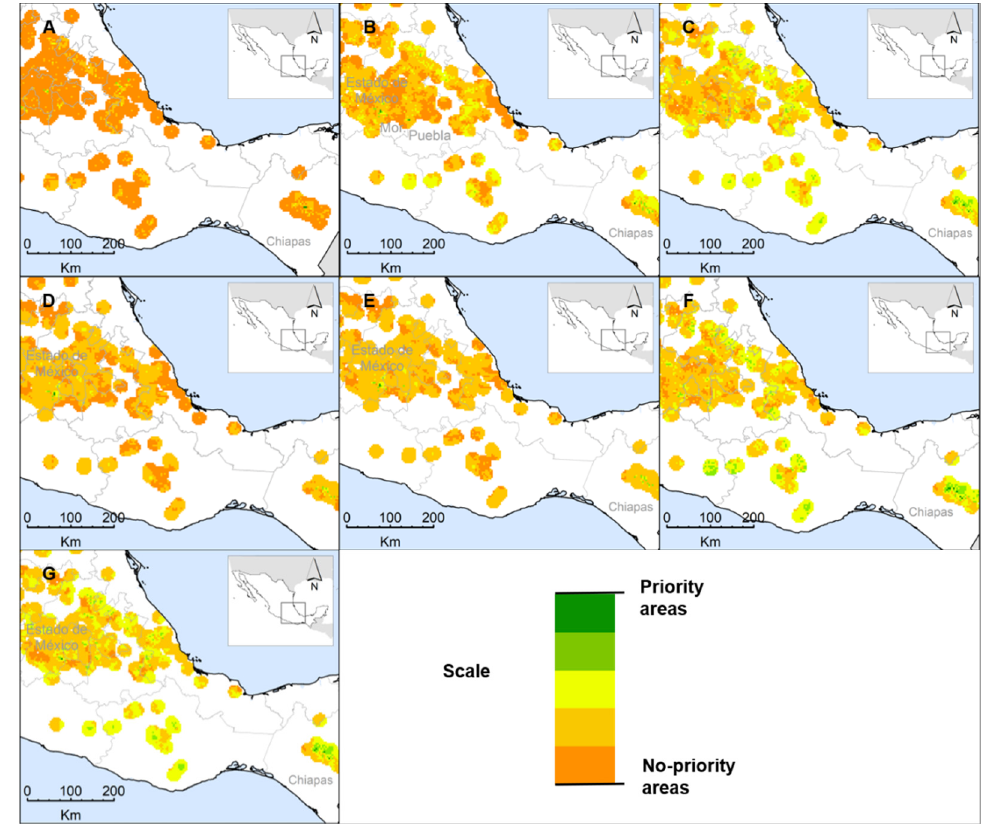
Figure 1. Priority area scenarios for the in situ conservation of wild hawthorn ( Crataegus spp.), based on seven different criteria-map combinations. ( A ) S 1 —All criteria with the same weight. ( B ) S 2 —All criteria with weights assigned by experts. ( C ) S 3 —All criteria with weights assigned by AHP. ( D ) E 4 —HIC-EXP with the same weight. ( E ) S 5 —HIC-EXP with weights assigned by experts. ( F ) S 6 —HIC-AHP with the same weight. ( G ) S 7 —HIC-AHP with weights assigned by AHP.